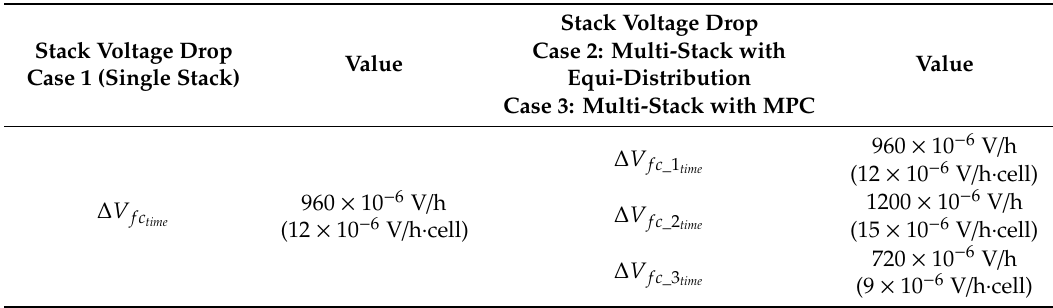
Table 4. Fuel cell degradation rates.